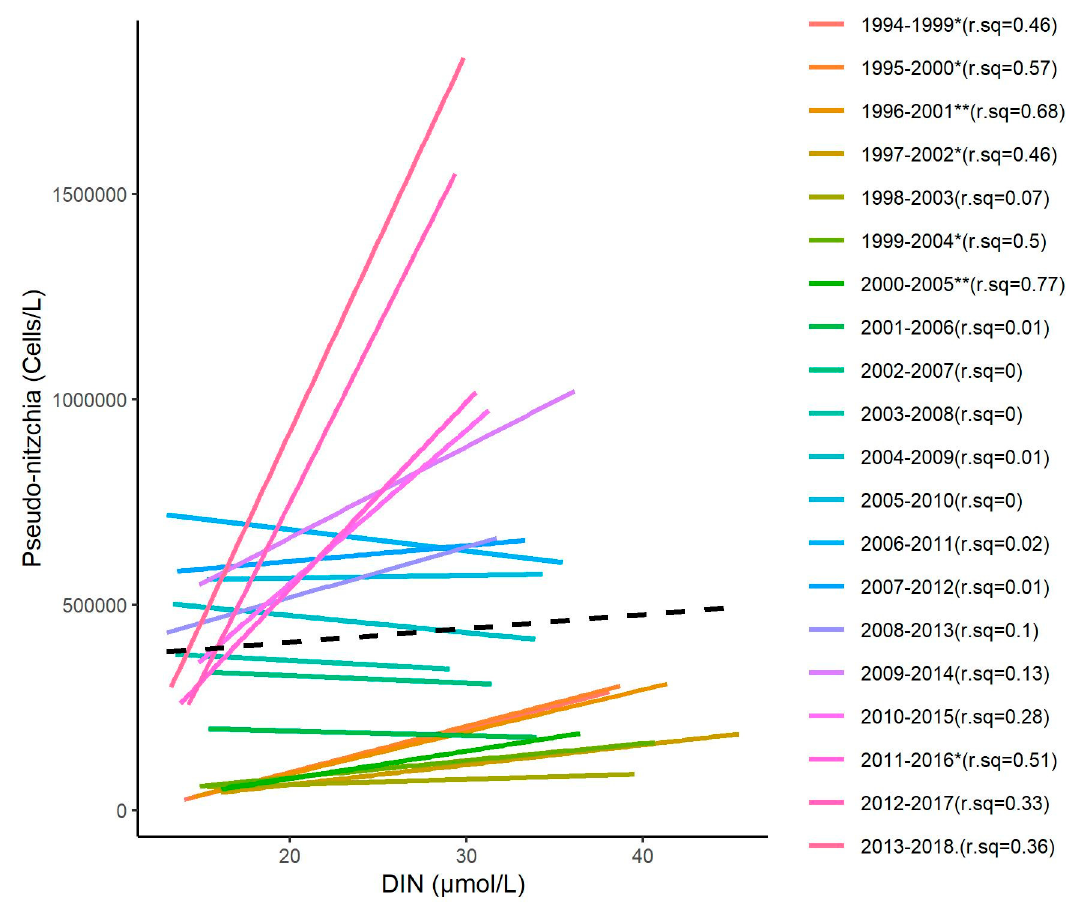
Figure A5. Linear regressions of the relationship between Pseudo-nitzchia and Dissolved Inorganic Nitrogen (DIN) concentrations by six-year sliding period. Input values for both variables are averaged maxima by period, calculated during the growing season for Pseudo-nitzchia and during the winter season for DIN. p -values as well as r-squared are indicated in the legend, next to each corresponding period (0 ‘***’ 0.001 ‘**’ 0.01 ‘*’ 0.05 ‘.’ 0.1 ‘ ’ 1).